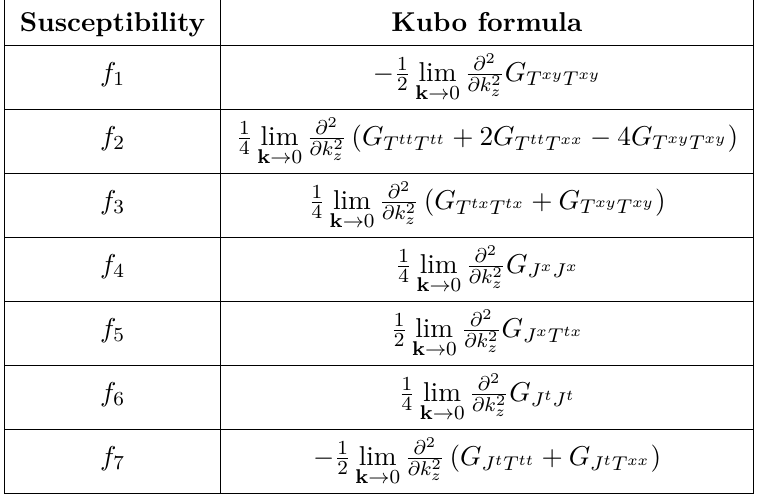
Table 2 . List of Kubo formulas for T -even second order thermodynamic susceptibilities f 1 , . . . f 7